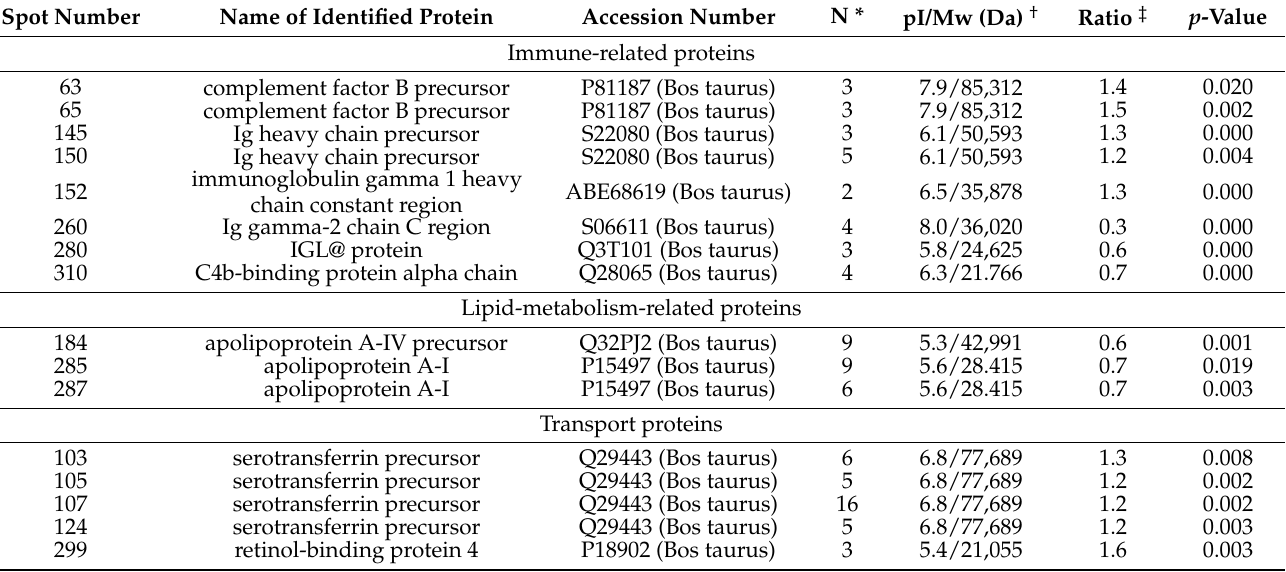
Table 1. Proteins identified by LC-MS/MS in spots showing statistically significant intensity differ- ence ( p < 0.05) between low- and high-PACAP (pituitary adenylate cyclase-activating polypeptide) -concentration groups.